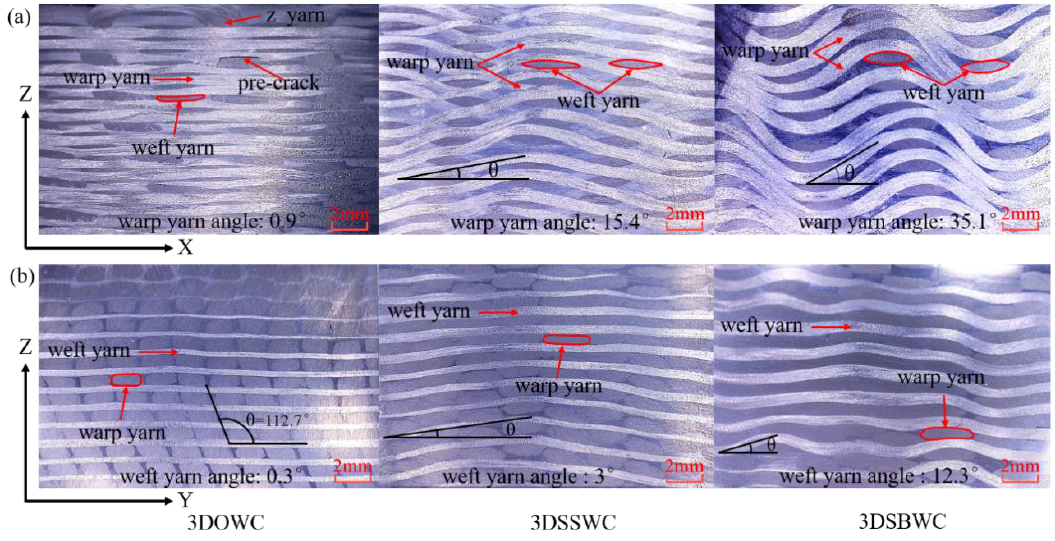
Figure 3. Cross-section of 3D composites along the ( a ) x-direction and ( b ) y-direction.